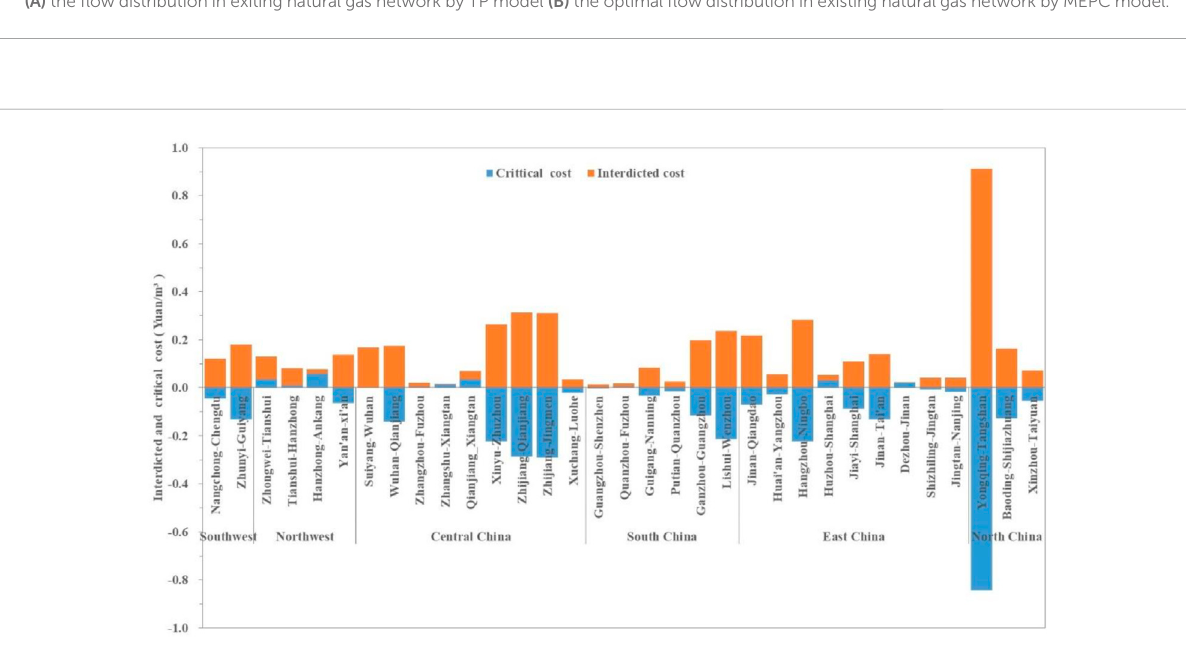
FIGURE 4 Spatial distribution of critical costs and interdicted costs of unoccupied gas